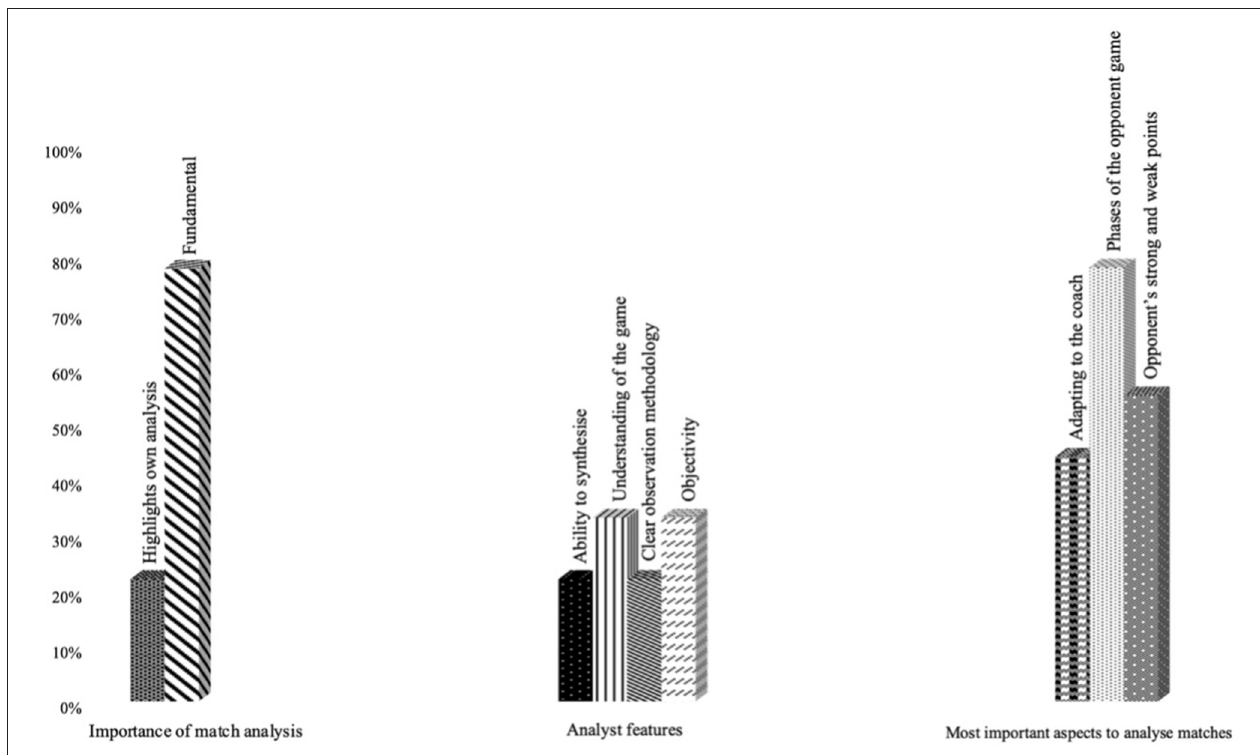
FIGURE 1 | Answer frequency of the categories of the first three questions for Objective